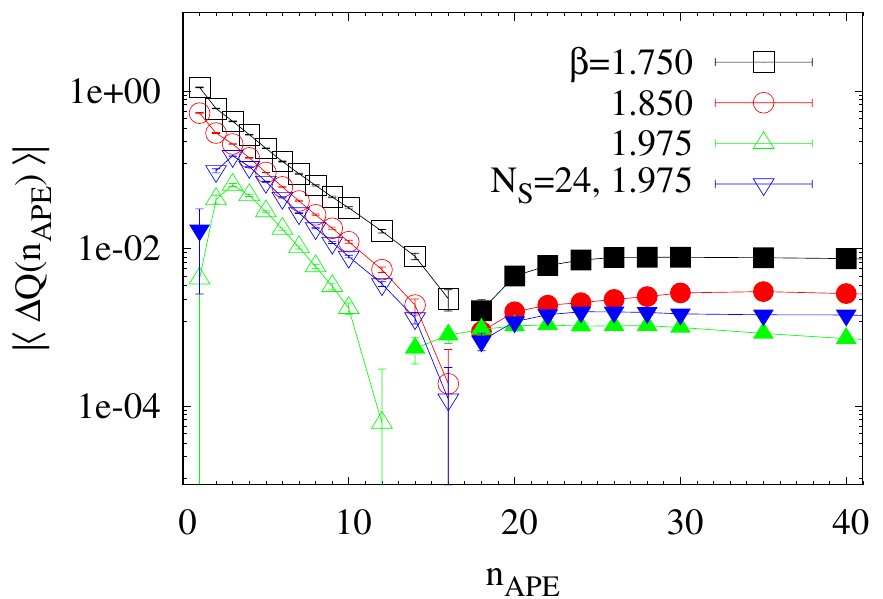
Figure 5 . The decay rate of the topological